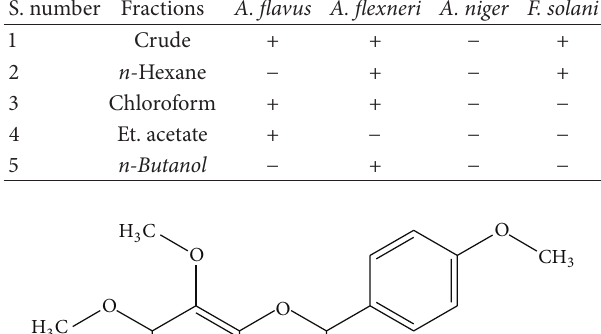
Table 2: Showing activity of different fractions against fungi. S. number Fractions